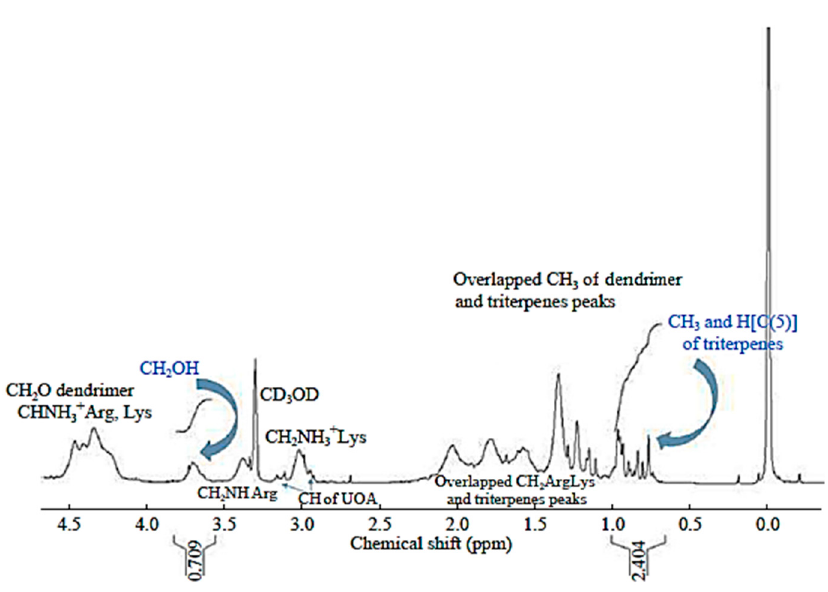
Figure 3. 1 H NMR spectrum of G4R(16)K(19)UOA(4) (300 MHz, CD 3 OD).